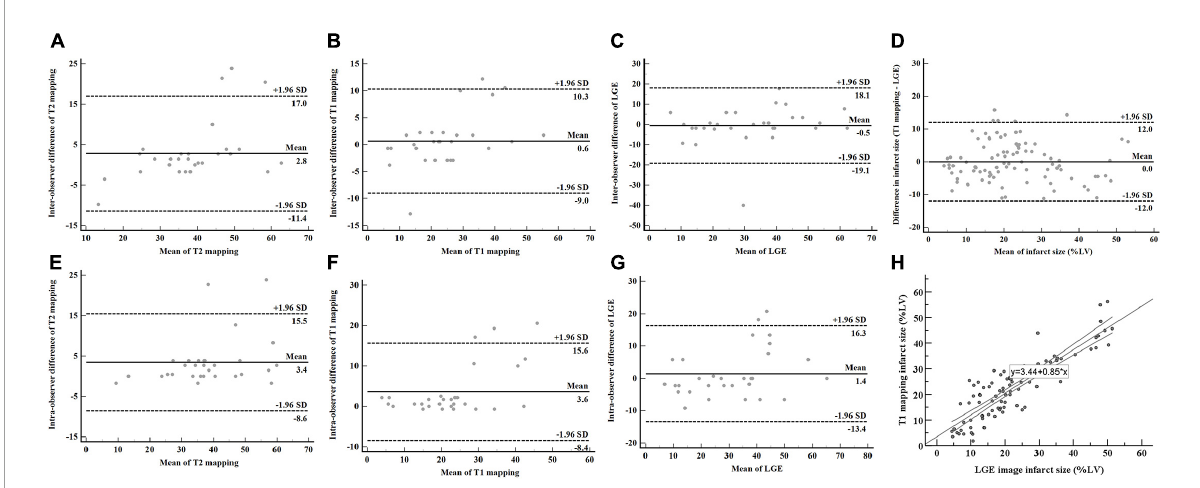
FIGURE6 AAR and IS assessed by T2 mapping, T1 mapping, and LGE. The intraobserver and interobserver reproducibility of T2 mapping (A,E) , T1 mapping (B,F) , and LGE (C,G) were good. Bland-Altman analysis showed good agreement in measuring IS between T1 mapping and LGE (D) . T1 mapping correlated well with LGE in quantifying IS (H) . AAR, area at risk; IS, infarct size; LGE, late gadolinium